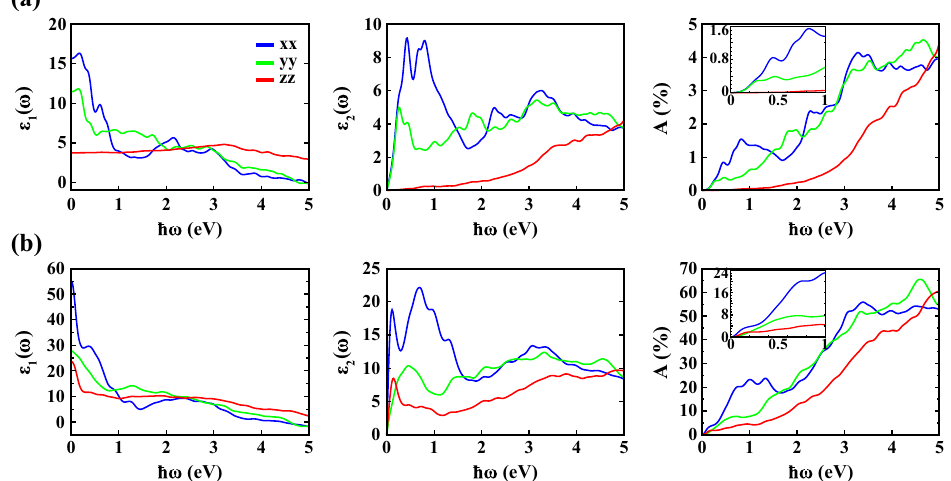
Figure 3. Real ( ε 1 (ω) ) and imaginary ( ε 2 (ω) ) parts of the frequency dependent dielectric constant, and absorbance ( A ) calculated within PBE+SOC for ( a ) 1L and ( b ) 4L 1T ′ WTe 2 as a function of photon energy ( (cid:31) ω ) at 0 K along different crystallographic directions ( xx , yy , zz